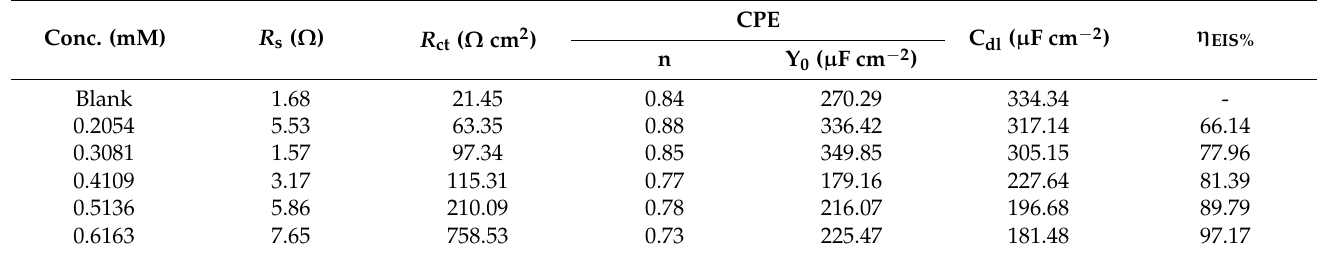
Figure 8. Bode phase angle ( Left ) and frequency ( Right ) plots of mild steel for a blank and inhibited solution having varying concentrations of CMEA at 30 °C in 1 M HCl. Table 5. EIS variables for MS in 1 M HCl in lack and existence of CMEA at 30 ◦